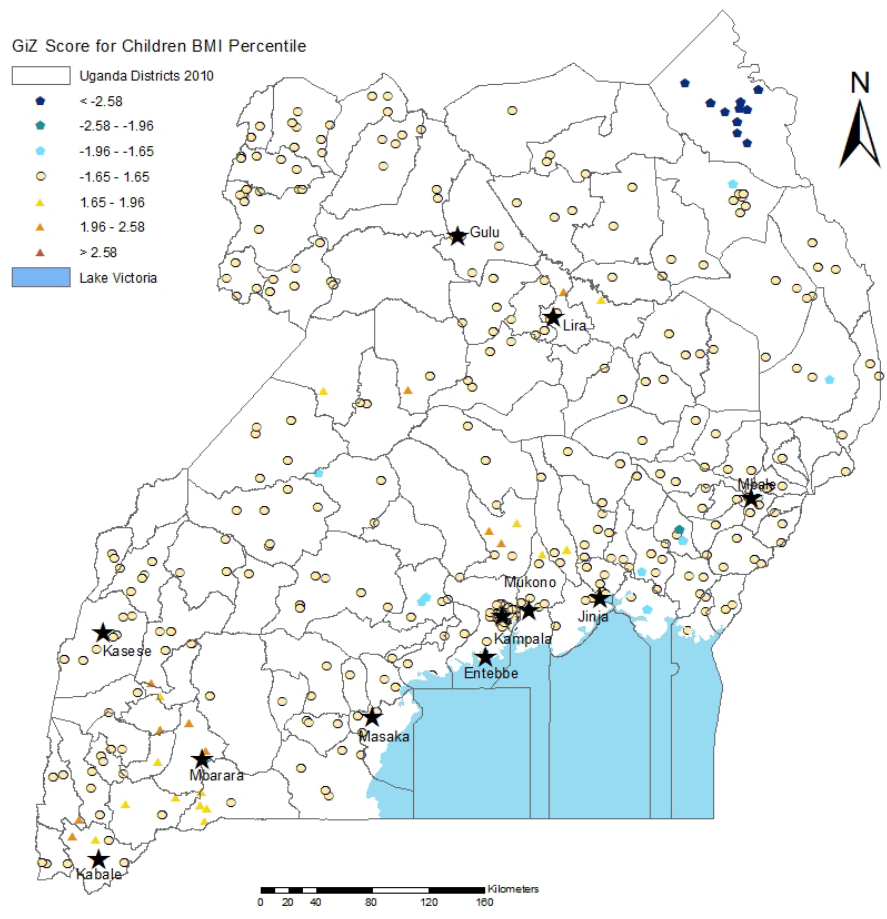
Figure 4. Hot and cold spots of child BMI percentile. Dark red dots represent hot spots of high child BMI percentile, and dark blue dots represent cold spots of low child BMI percentile at the 95% statistical significance level. Each dot represents a cluster of DHS sample households, while the boundaries shown are districts. Dots inside Lake Victoria are located on